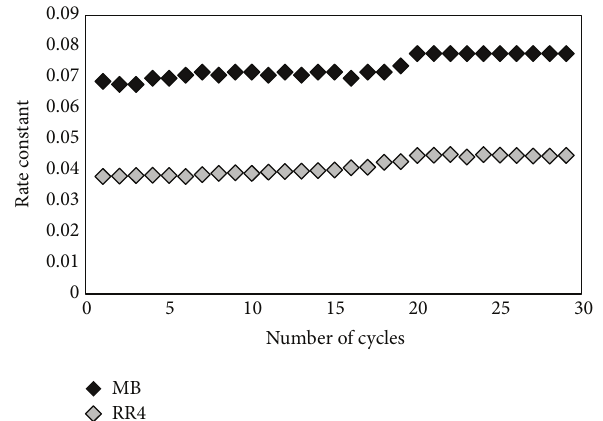
Figure 3: Photocatalytic degradation rate of RR4 and MB under reusability effect.